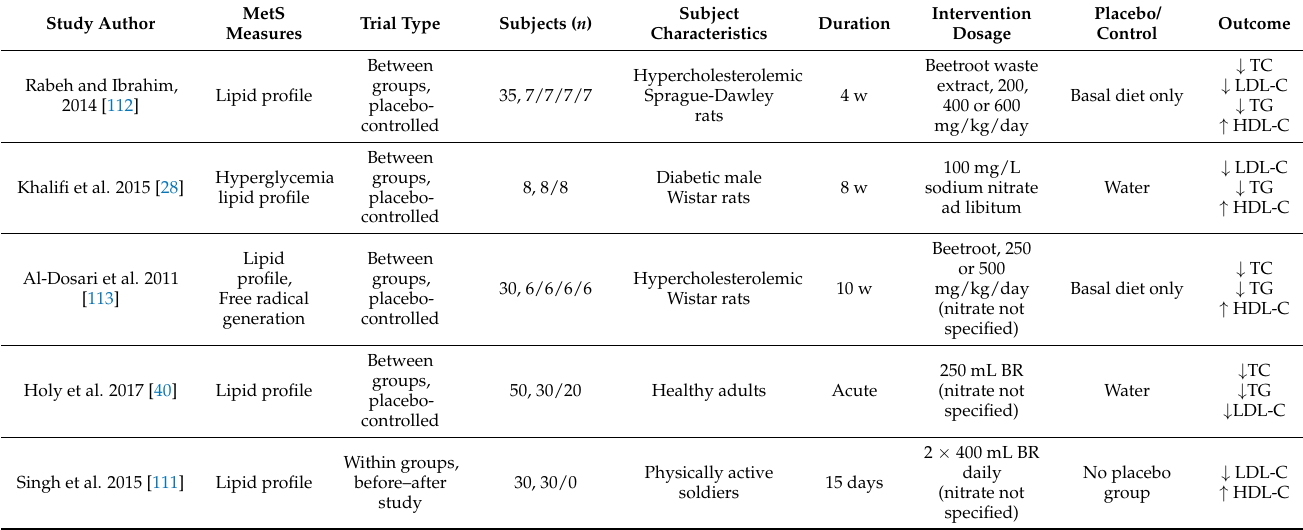
Table 5. Details of beetroot and dietary nitrate trials investigating